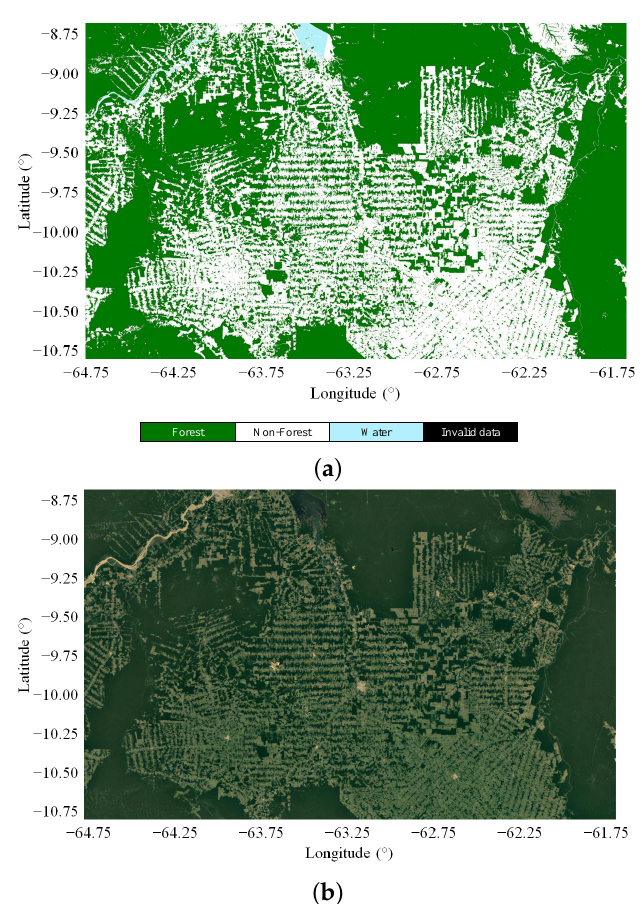
Figure 9. ( a ) Detail of the TanDEM-X FNF map over the Brazilian state of Rondônia, generated using input images acquired during the first TanDEM-X global coverage (2011). ( b ) Optical image from Landsat acquired over the same area.